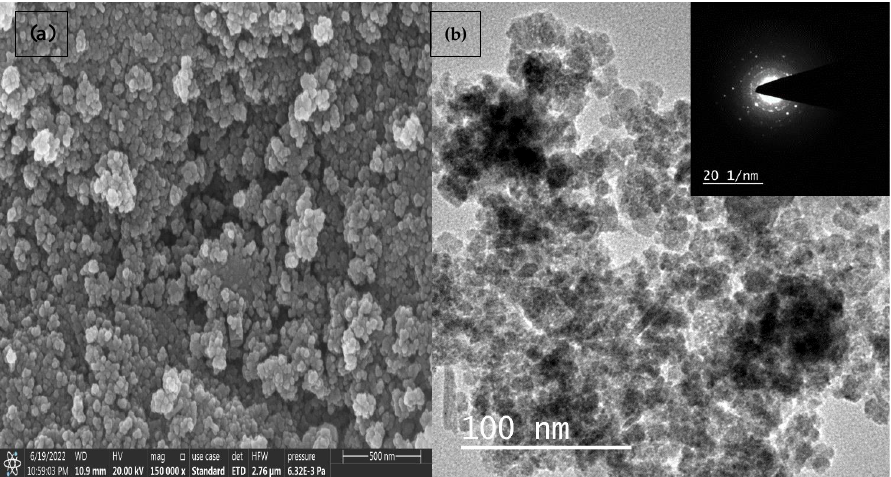
Figure 3. Shows ( a ) FE-SEM and ( b ) TEM of Fe-Mn bimetallic catalyst; inset of TEM image shows selected area electron diffraction (SAED)